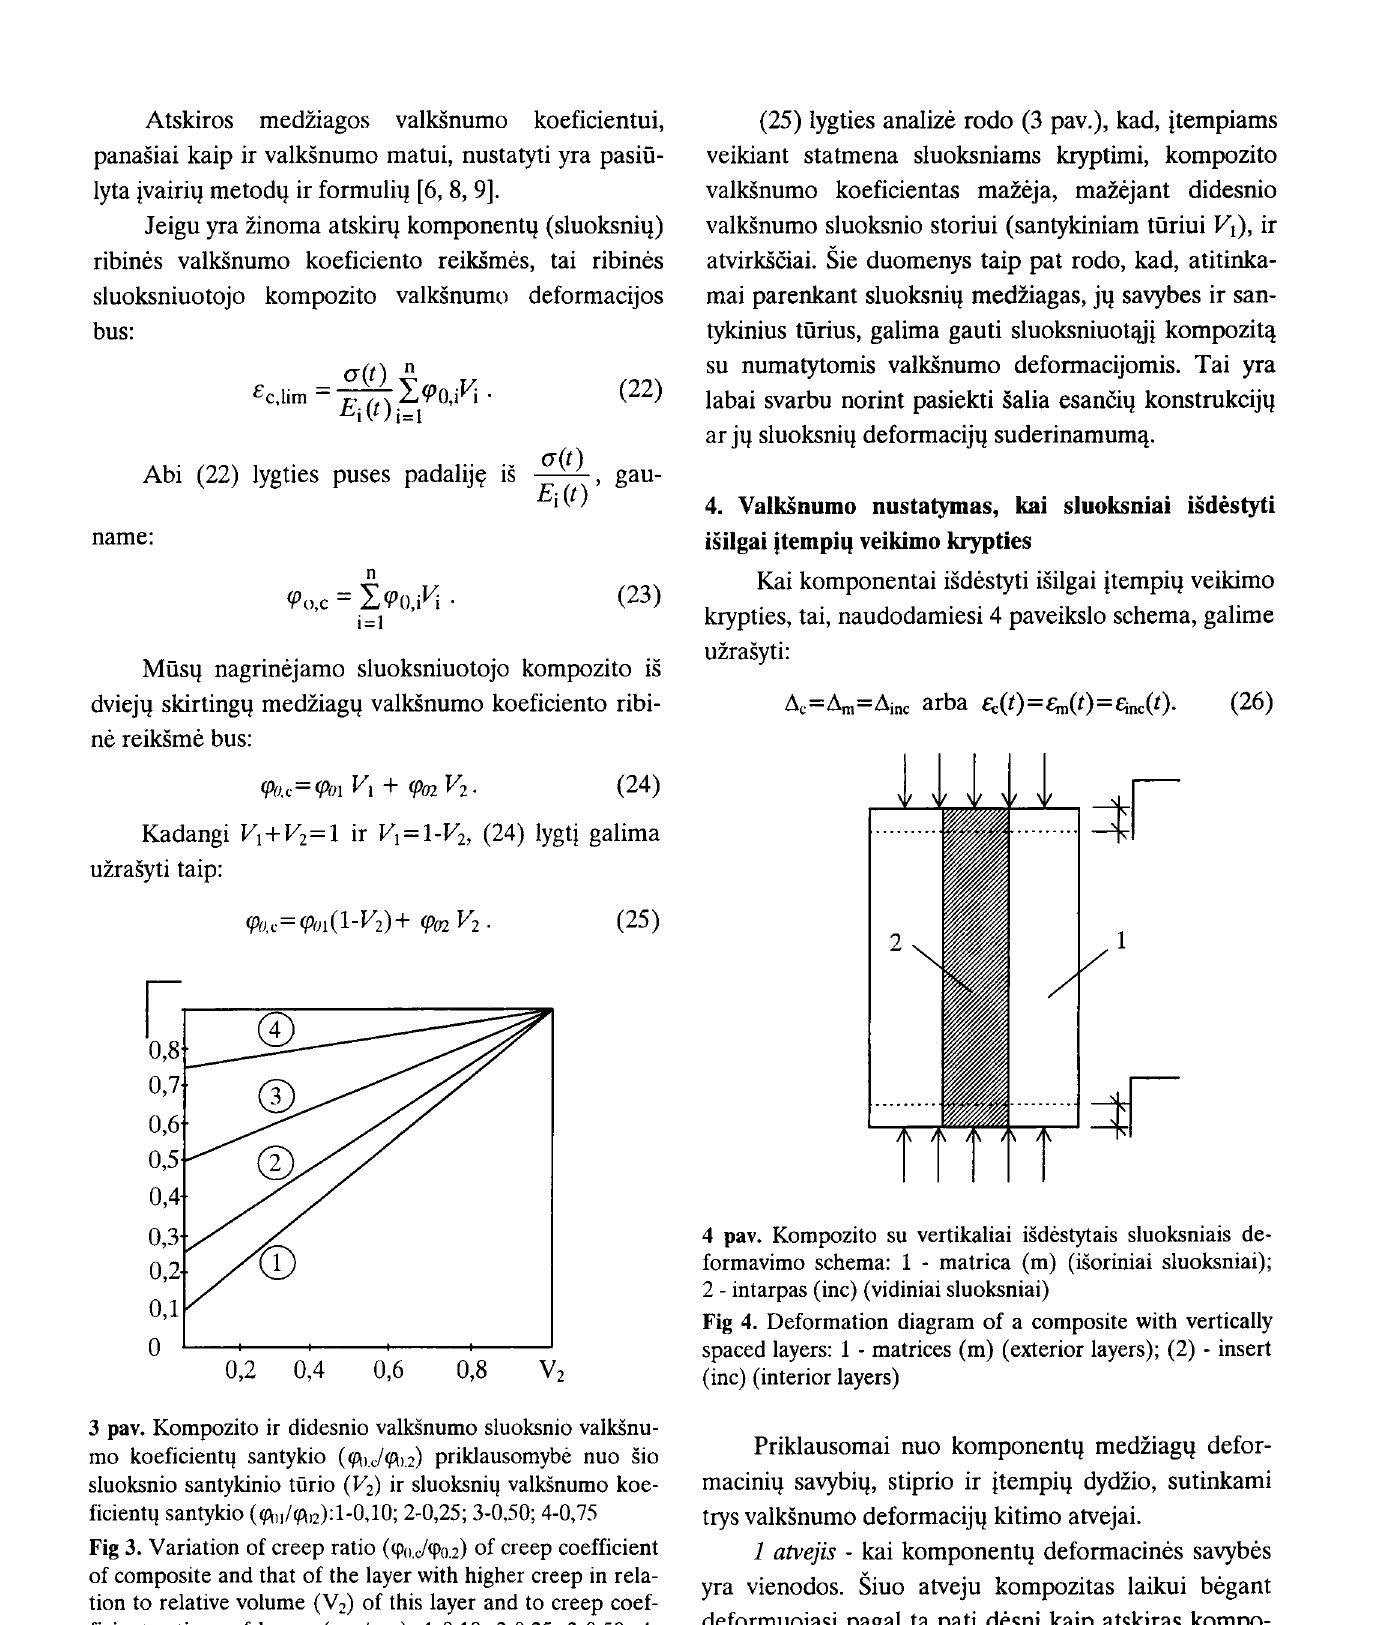
(25) lygties analize rodo (3 pav.), kad, itempiams